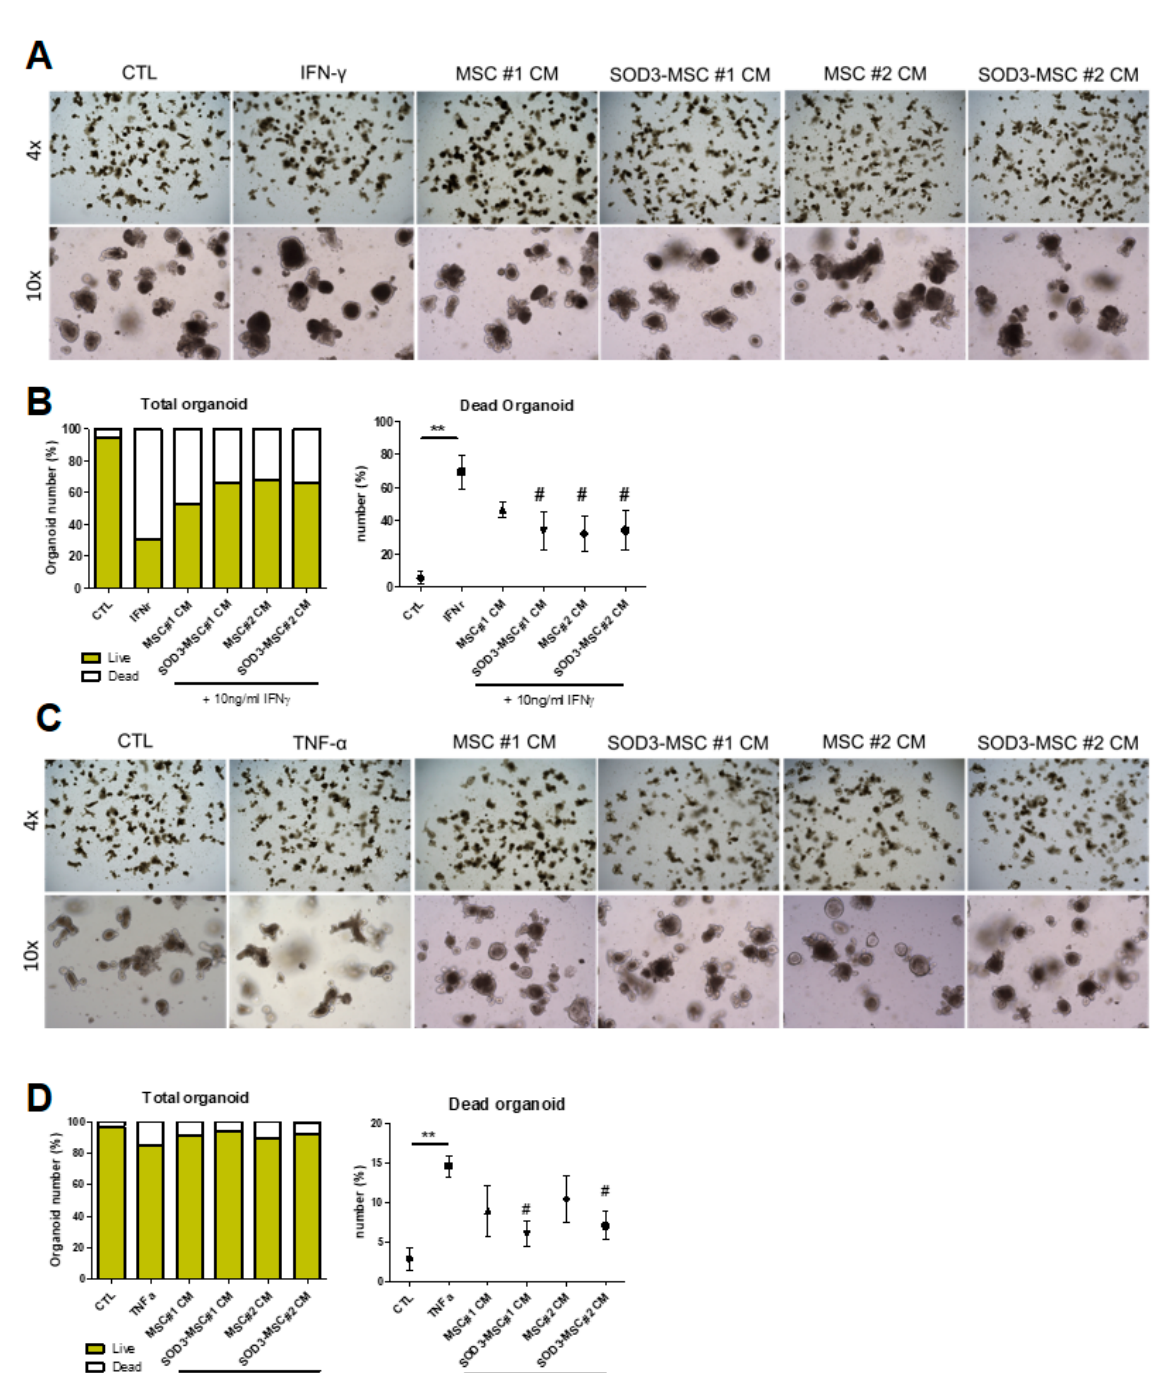
Figure 7. The protective impact of SOD-MSCs on pro-inflammatory cytokine-treated IOs. ( A , C ) The representative bright-field images of IFN- γ ( A ) or TNF- α ( C ) treated IOs. Upon IFN- γ treatment, IOs lost their budding structure and unorganized cellular aggregates appeared instead due to a broken epithelial lining. ( B , D ) Live/dead organoid counting results upon IFN- γ ( B ) or TNF- α ( D ) treatment. Both control- and SOD3-MSC-CM protected IOs from pro-inflammatory damage. At least three individual experiments were performed. ** p < 0.01 (CTL vs. IFN- γ or TNF- α ), # p < 0.05 (IFN- γ or TNF- α vs. MSC-CM). Results are shown as mean ± SD. Results show one representative experiment of at least three independent